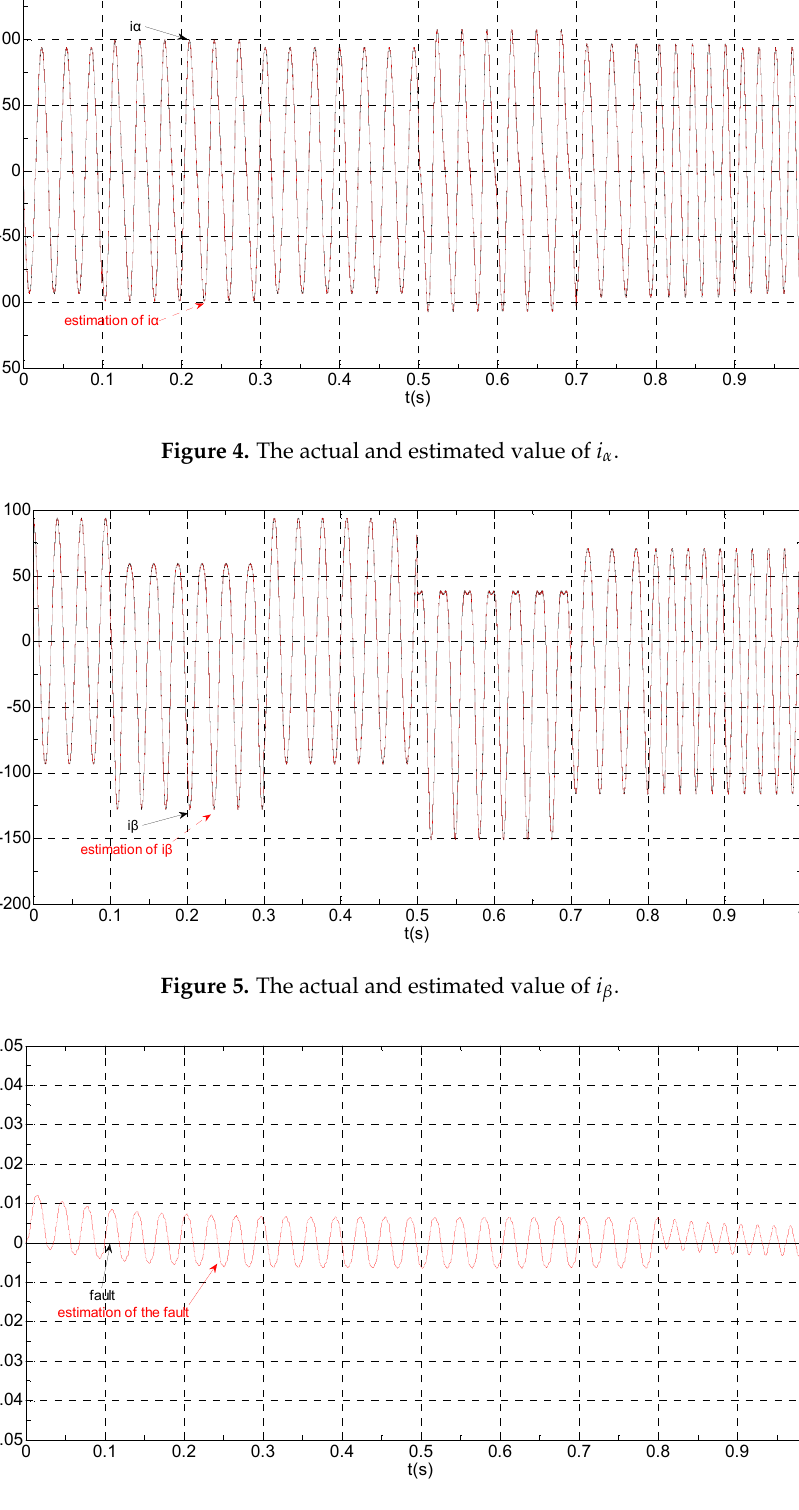
Figure 6. The current sensor fault and its reconstruction in phase “a”.